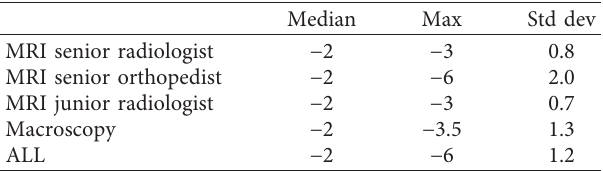
Table 5: Reliability without PSI (in mm).